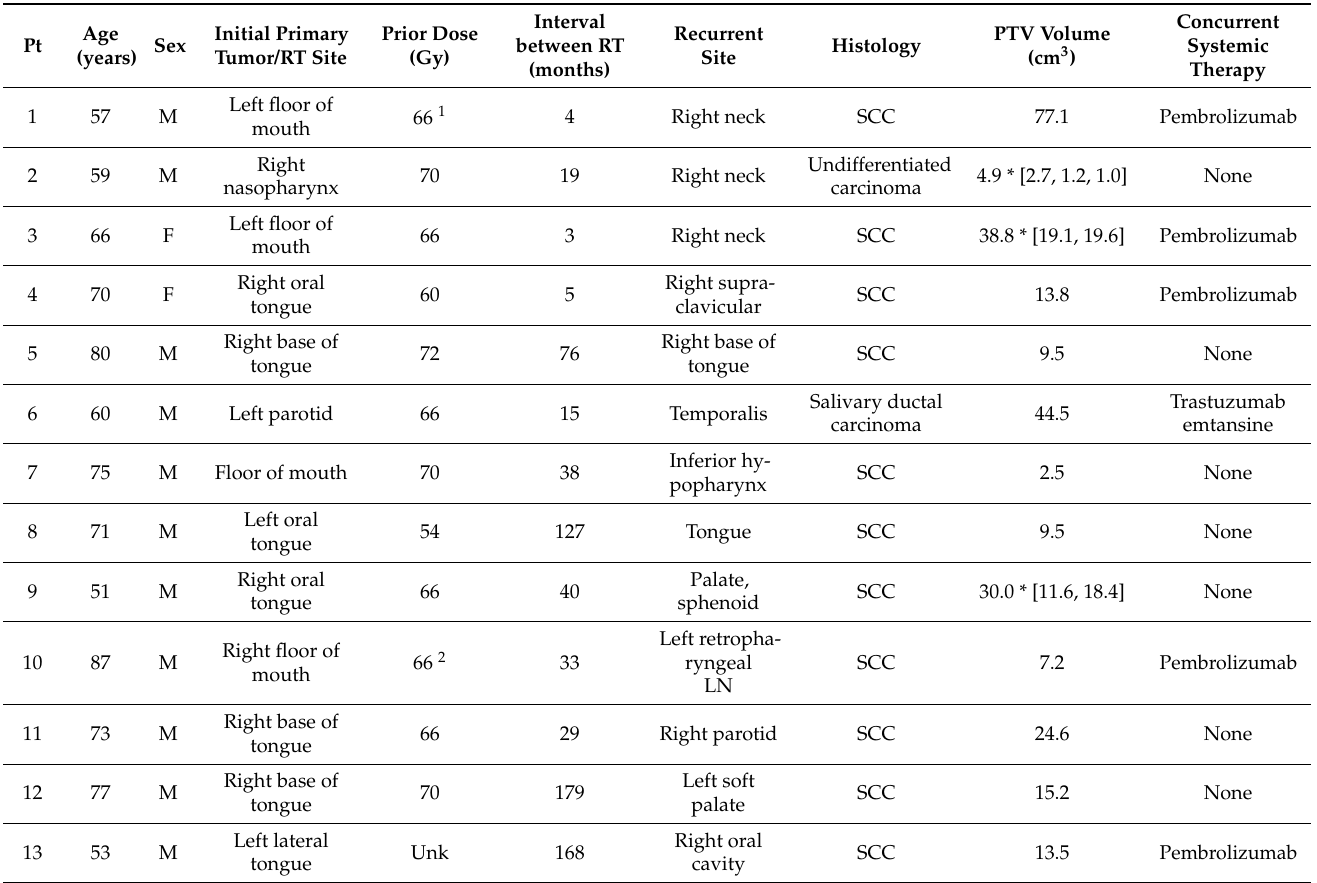
Table 1. Patient